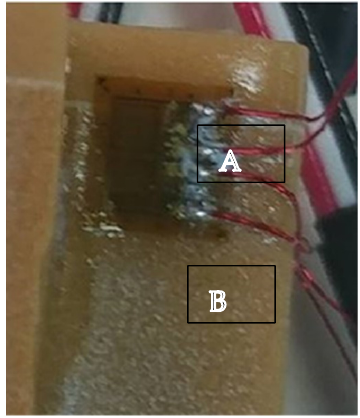
Figure 3. The strain gauges ( A ) connected directly to the sawbone ( B ) surface in the cervical part of the implant.